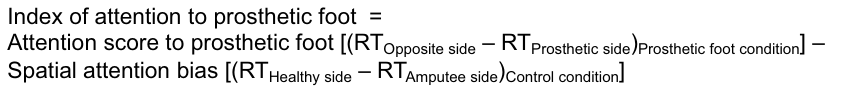
Figure 6. Formula for calculating the index of attention to the prosthetic foot. RT: reaction